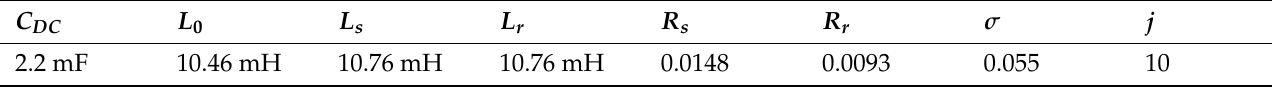
Table 2. IM Parameter for Flywheel